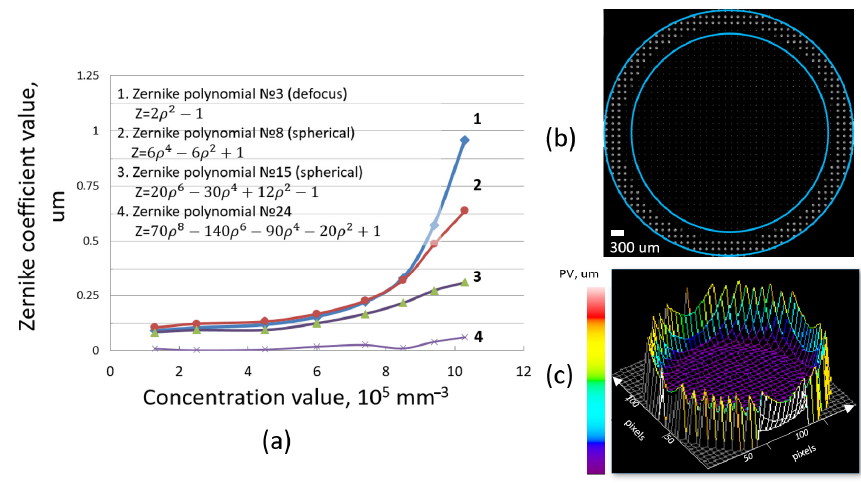
Figure 4. ( a ) Dependence of Zernike coefficients of symmetric distortions (defocus and spherical aberrations) on the concentration value. ( b ) Simulated hartmannogram. White dots are focal spots generated by the photons that passed through the scattering medium, fell on the microlens array and were registered on the sensor plane. Inner blue circle shows the initial beam diameter (before it enters the scattering medium), outer blue circle shows the region where new focal spots appear due to the beam scattering. ( c ) A typical view of the surface of the averaged wavefront. PV (“peak-to-valley”) parameter shows an amplitude of averaged wavefront distortions.